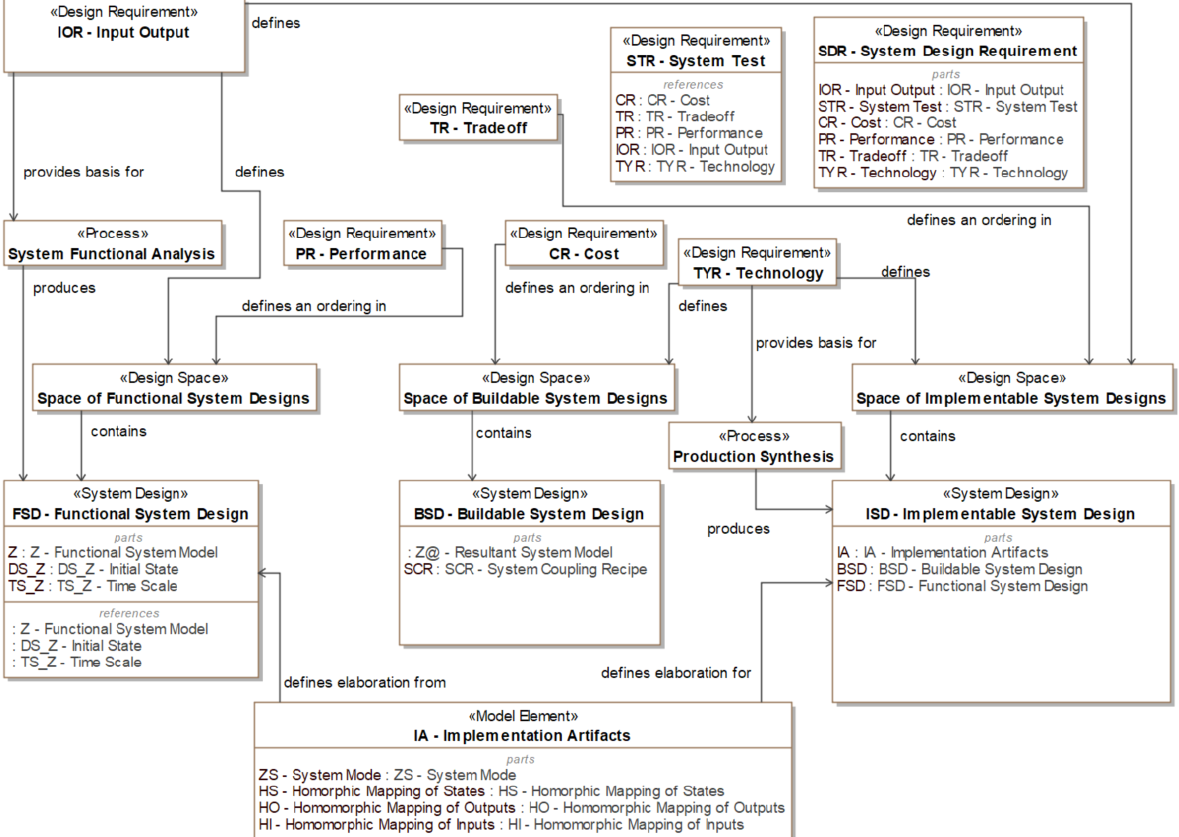
Figure A1. The full metamodel of T3SD. A description of the T3SD Implementable Perspective showing designs that meet the required input/output, have a homomorphic relationship between the functional and buildable designs, meet the required technology, and are ordered according to the preferred tradeoff.